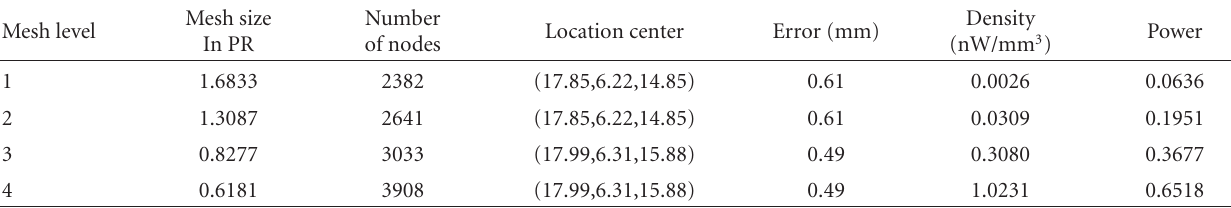
Table 4: Reconstruction results for 3D atlas model on di ff erent mesh